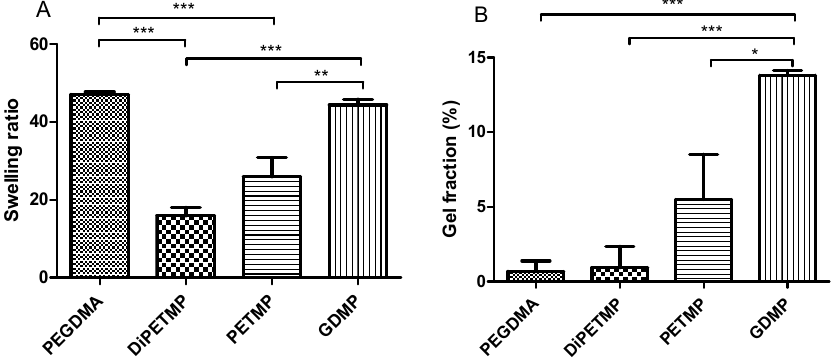
Figure 8. Comparison between ( A ) the swelling characteristics and ( B ) the gel fraction values of the PEGDMA and thiolated PEGDMA hydrogels.